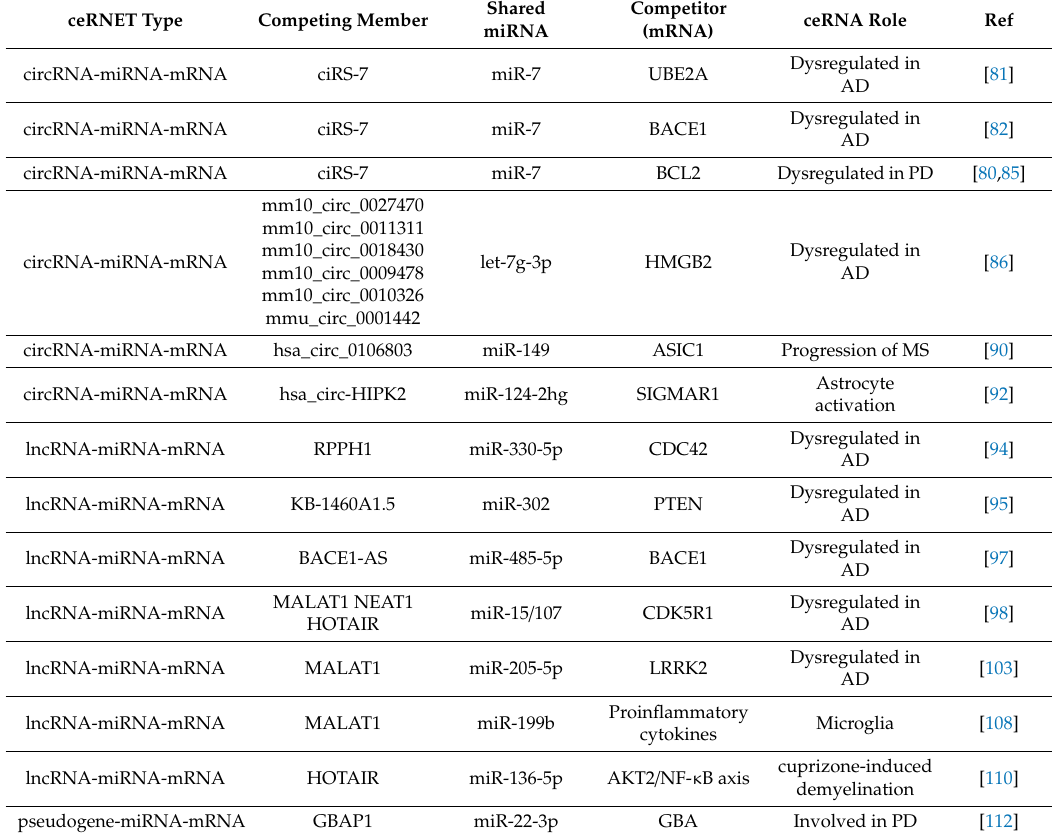
Table 1. Neuroinflammatory-related ceRNA networks (ceRNETs) reported in NDDs. For each ceRNET, the competing member (circRNA, lncRNA, or pseudogene), competitor, and shared miRNA are